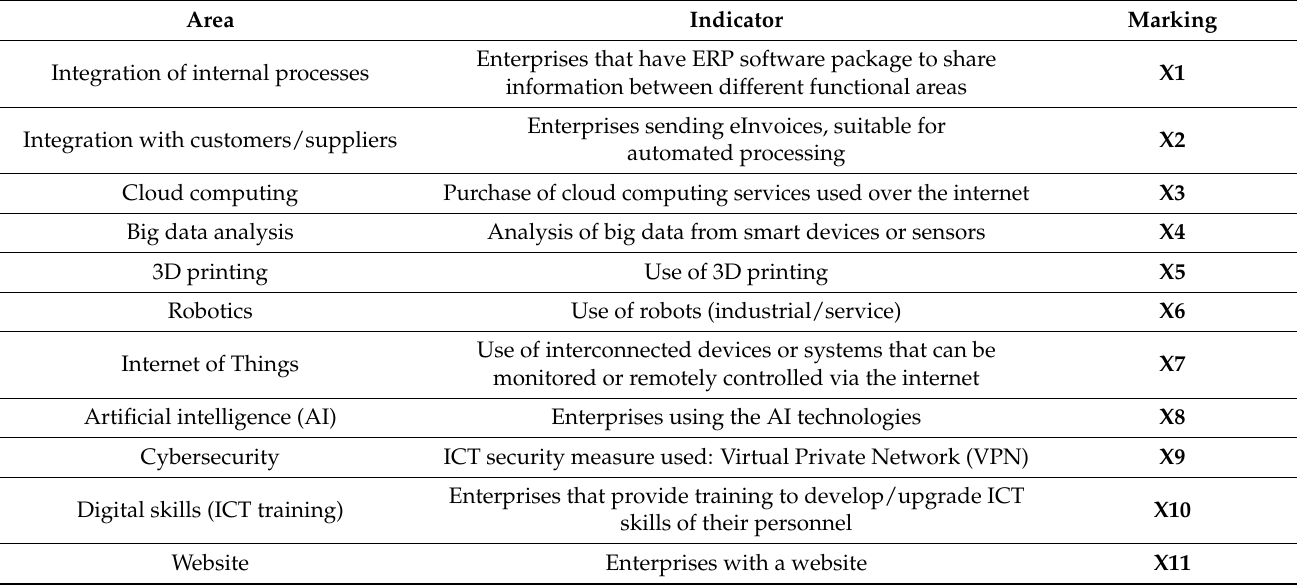
Table 2. The list of indicators characterizing the level of SME digitalization in the EU-27 countries.